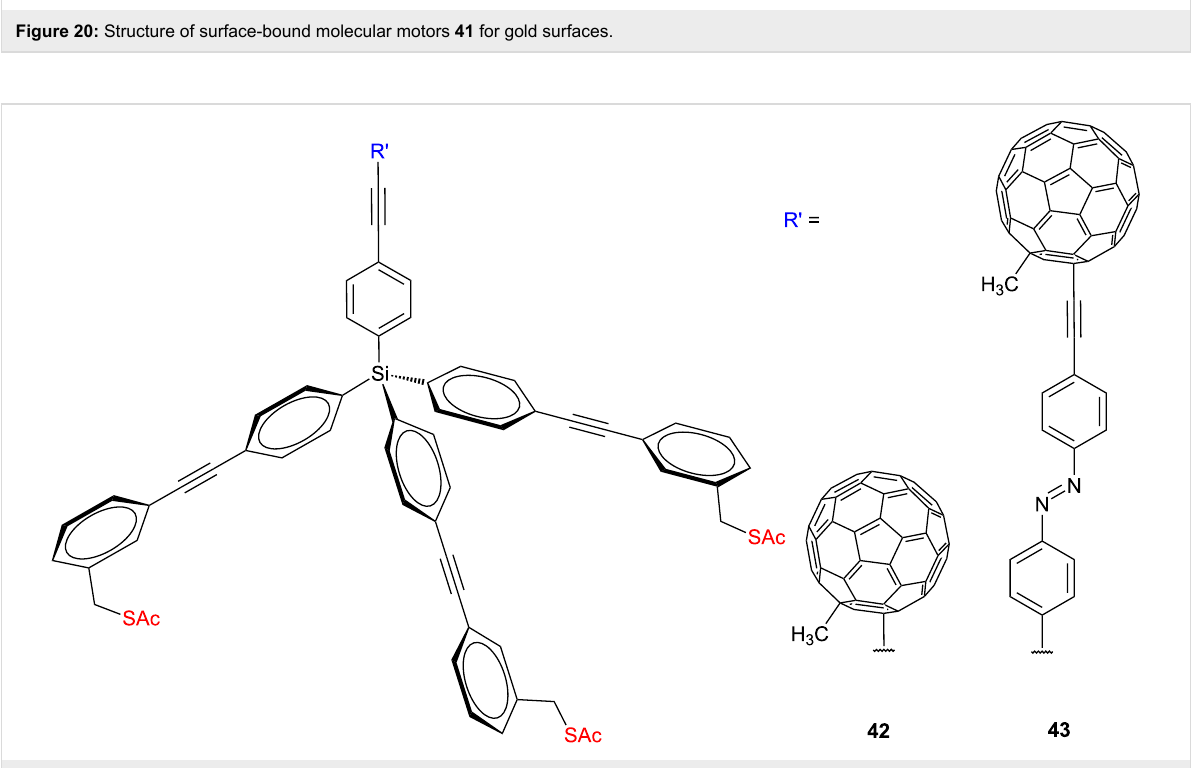
Figure 21: Fullerene-terminated tetraphenylmethane platforms 42 and 43